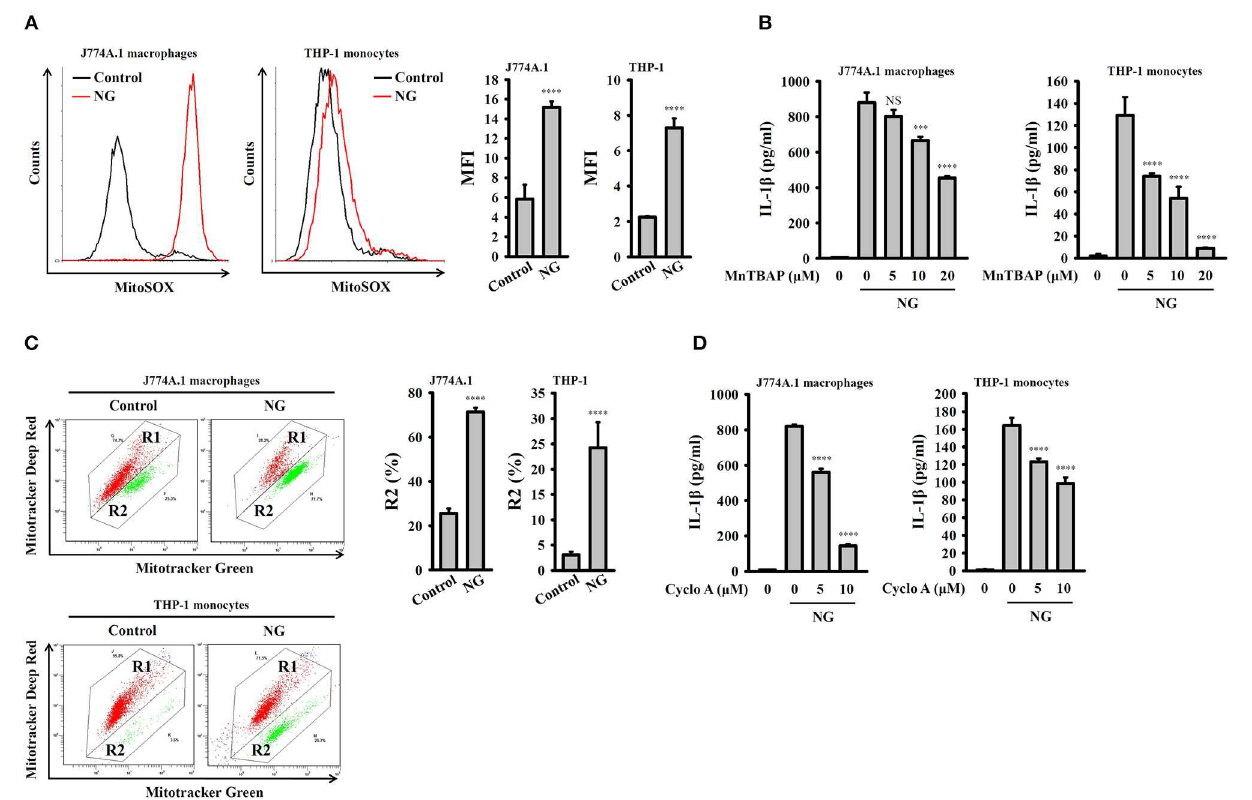
FIGURE 8 | Activation of the NLRP3 inflammasome by NG through mitochondrial damage. (A) J774A.1 macrophages or THP-1 monocytes were infected for 4h with NG at 50 or 20 MOI, respectively. The mitochondrial ROS levels in the cells were measured by staining with MitoSOX. (B) J774A.1 macrophages or THP-1 monocytes were incubated for 0.5h with MnTBAP, followed by infection for 24h with NG at 50 or 20 MOI, respectively. The levels of IL-1 β in the supernatants were measured by ELISA. (C) J774A.1 macrophages or THP-1 monocytes were infected for 4h with NG at 50 or 20 MOI, respectively. The mitochondrial inner transmembrane potential and mitochondrial mass were measured by staining with MitoTracker Deep Red and MitoTracker Green, respectively. (D) J774A.1 macrophages or THP-1 monocytes were incubated for 0.5h with cyclosporine A (Cyclo A), followed by infection for 24h with NG at 50 or 20 MOI, respectively. The levels of IL-1 β in the supernatants were measured by ELISA. The flow cytometry and ELISA data are expressed as the mean ± SD of three separate experiments. A significant difference at the level of *** p < 0.001 and **** p < 0.0001, respectively, compared to untreated control cells (A,C) or NG-infected cells (B,D) . NS, not significant (One-way ANOVA with Dunnett’s multiple comparisons